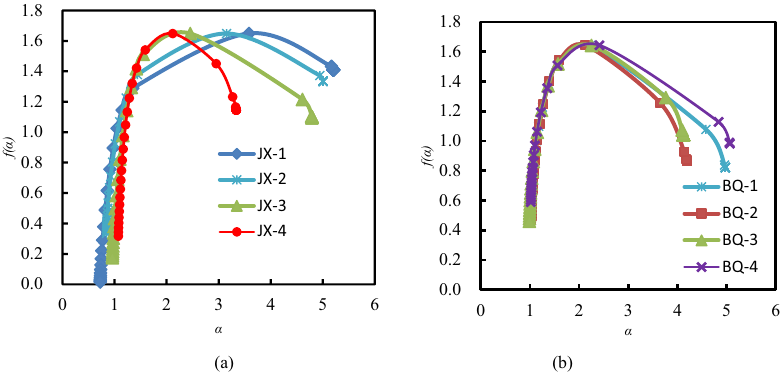
Figure 7. Multifractal singular spectrum of coal samples.